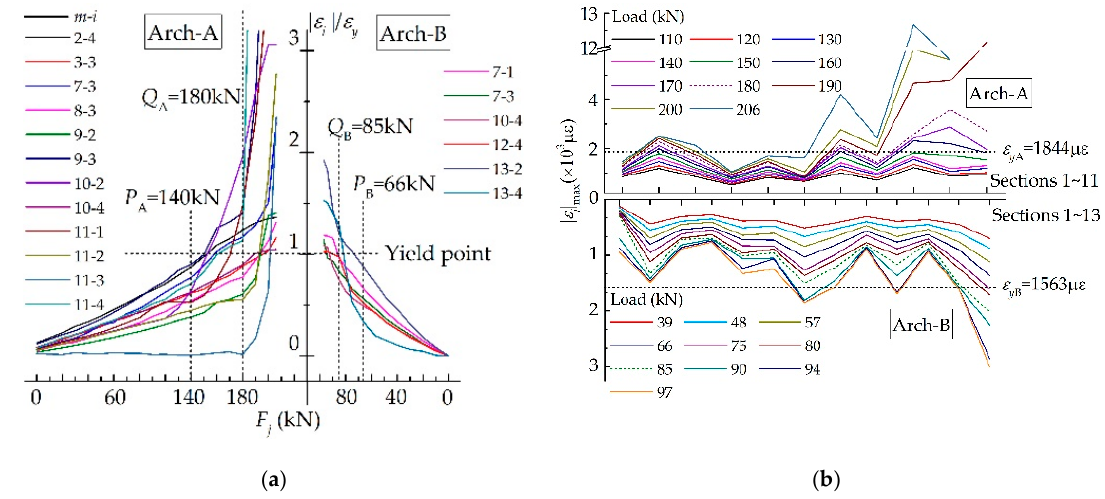
Figure 8. The distribution curves of experimental strains: ( a ) | ε i |/ ε y - F j curve of two arch models; ( b ) the distribution mode curve of | ε i | max . (Note: m - i denotes ε i of m -th cross-section, i = 1, 2, 3, 4.).